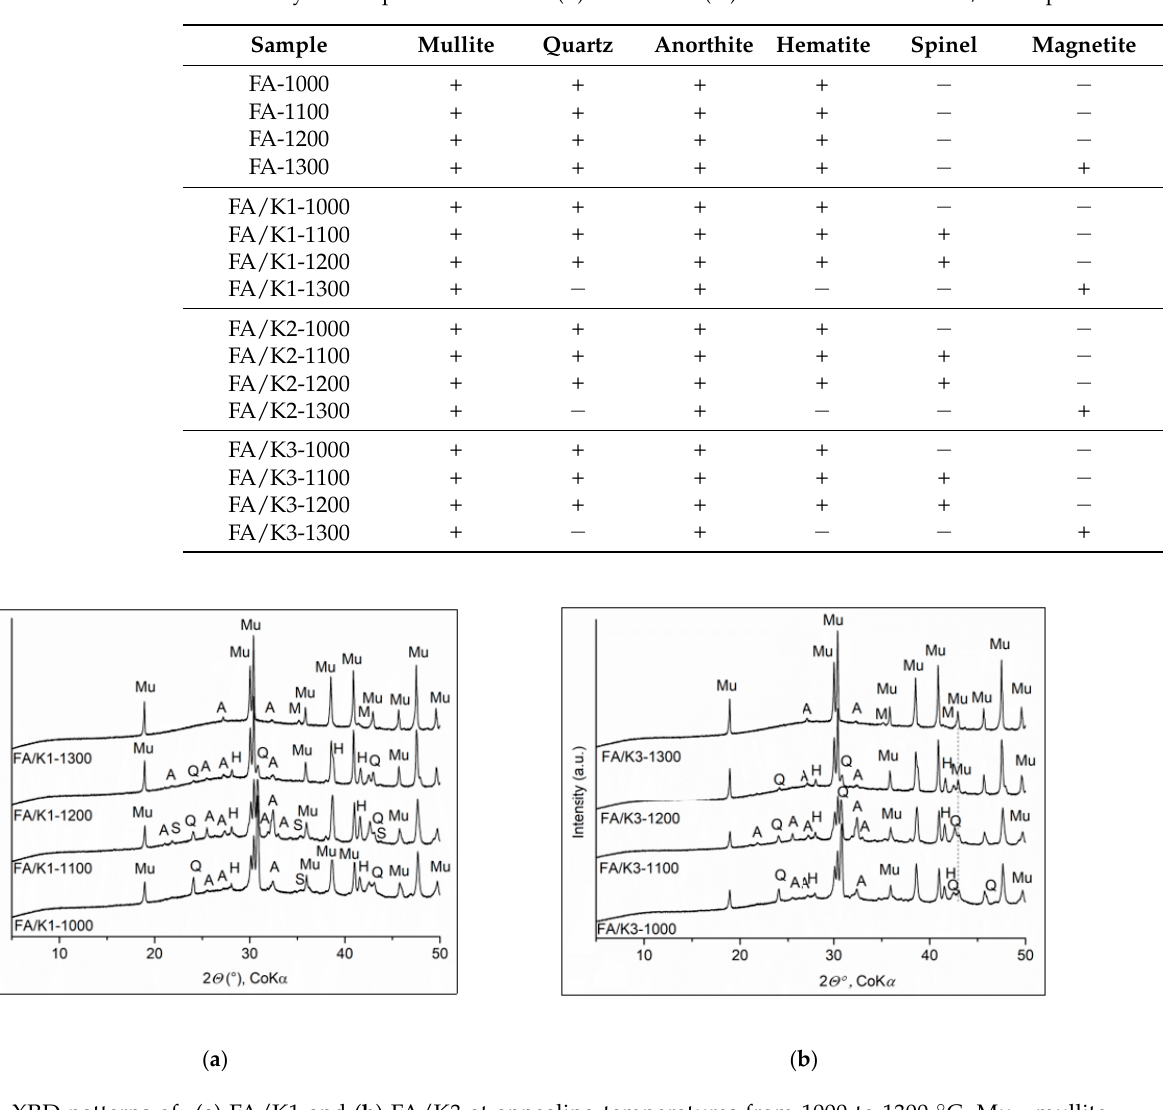
Figure 3. XRD patterns of: ( a ) FA/K1 and ( b ) FA/K3 at annealing temperatures from 1000 to 1300 °C. Mu—mullite, Q— quartz, A—anorthite, H—hematite, S—spinel and M—magnetite. Table 4. Shrinkage, Porous Values and Compressive Strength of Annealed Samples.